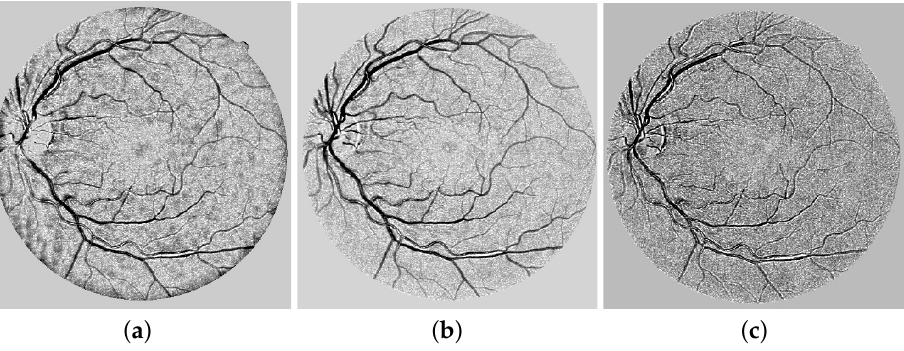
Figure 5. Morphological Operation Output ( a ) Morphological Operation Output: Red Chan- nel. ( b ) Morphological Operation Output: Green Channel. ( c ) Morphological Operation Output: Blue